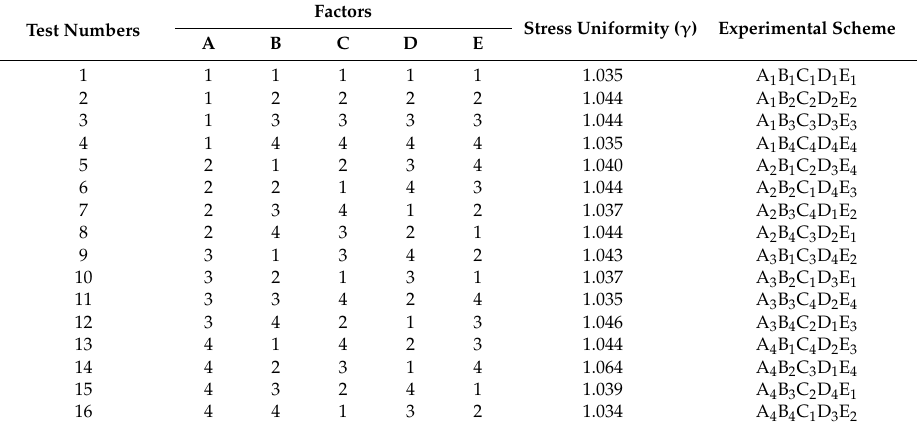
Table 7. Orthogonal table and simulation results (310